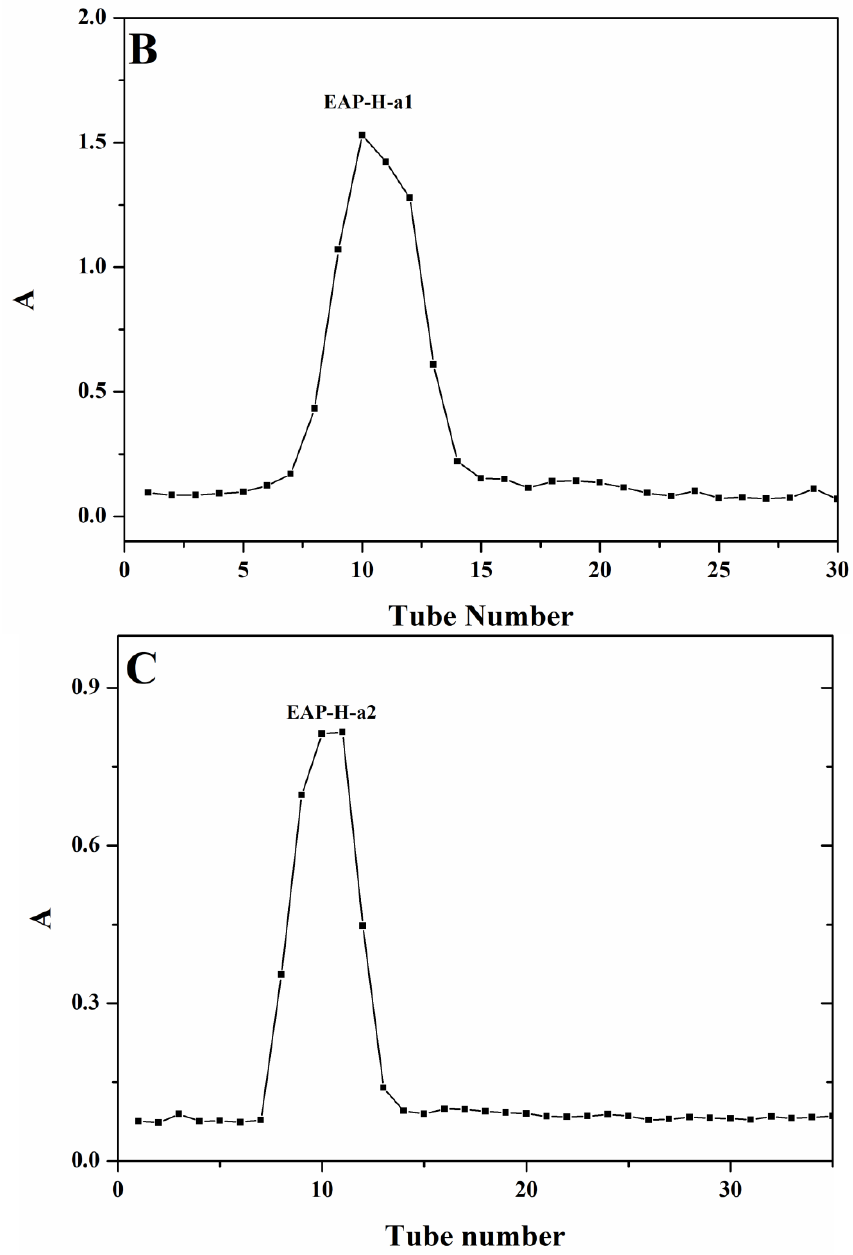
Figure 1. Stepwise elution curves of the polysaccharide fractions using DEAE Sepharose-52 chro- matography ( A ); Sephadex G-75 chromatography elution curve of different fractions ( B , C ).